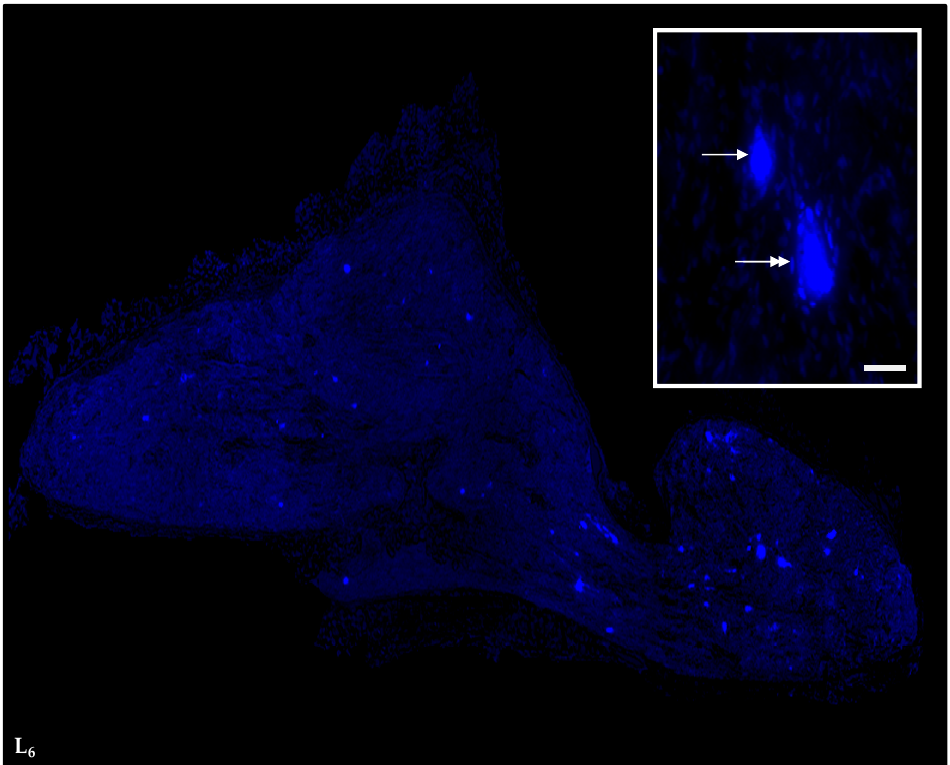
Figure 8. Consecutive microphotographs-based reconstruction of a paramedian section of the L 6 SChG demonstrating intraganglionic distribution pattern of retrogradely-labeled small- (<25 µm) and large-sized (>25 µm) skin-projecting neurons. Insert: a fragment of a microphotograph made at a “working” magnification used for morphometric analysis of retrogradely-labeled perikarya; a typical small-sized neuron is indicated by an arrow, while a double-headed arrow points out to a large-sized cell. Scale bar in insert = 50 µm.